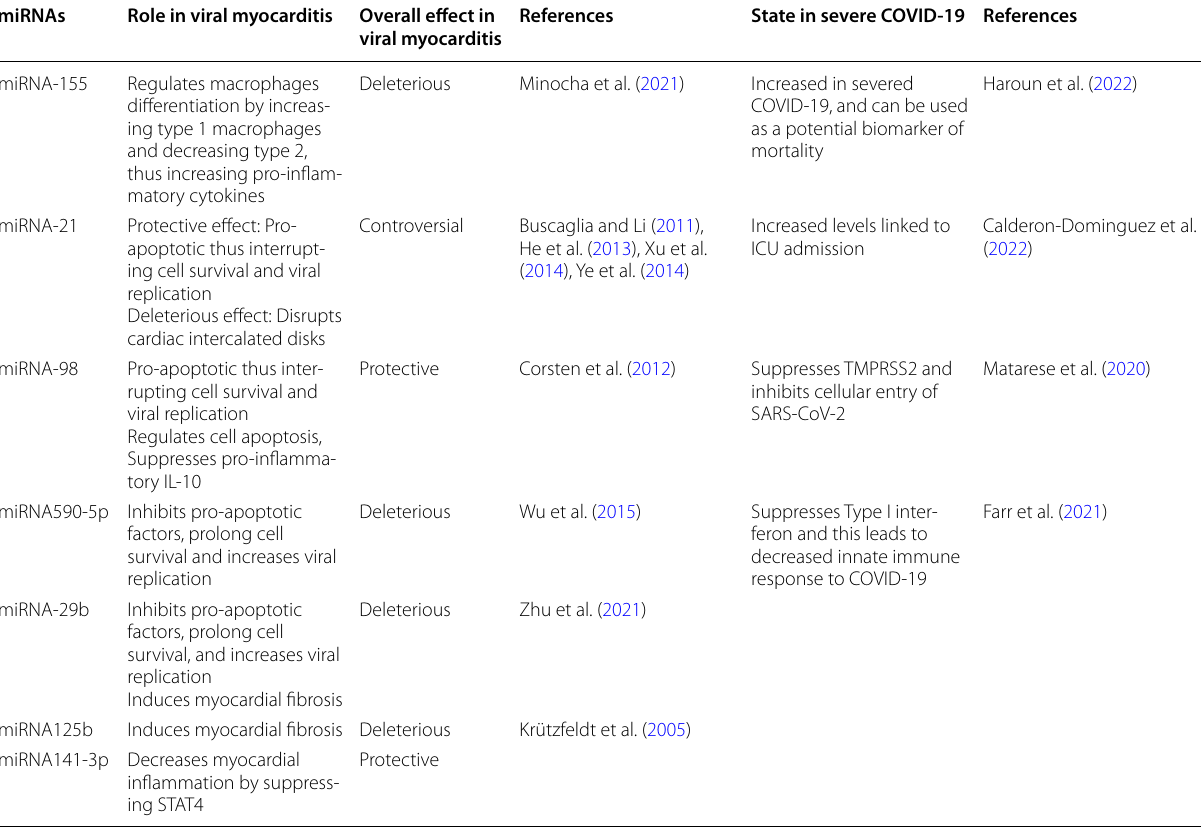
COVID-19 Coronavirus disease 2019, miRNA micro-ribonucleic acid, ICU Intensive Care Unit, IL Interleukin, SARS-CoV-2 severe acute respiratory syndrome coronavirus disease 2, STAT4 Signal transducer and activator of transcription 4, TMPRSS2 transmembrane serine protease 2, VMC viral